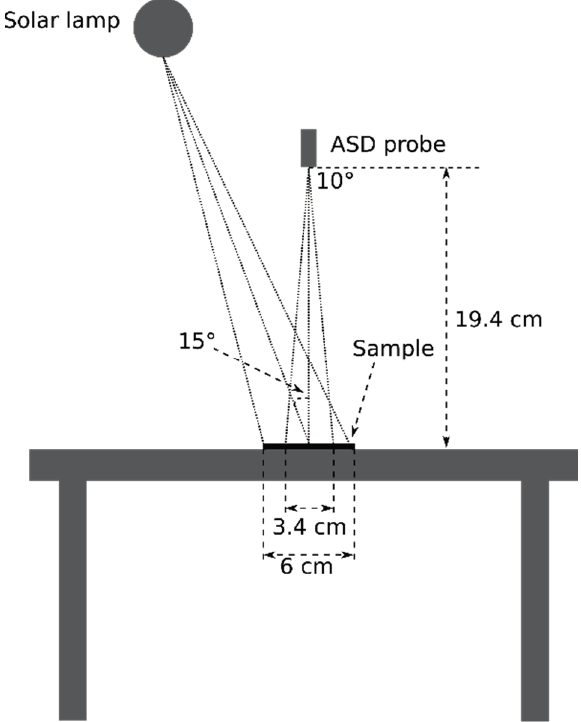
Figure 3 . Experimental set-up for soil spectra